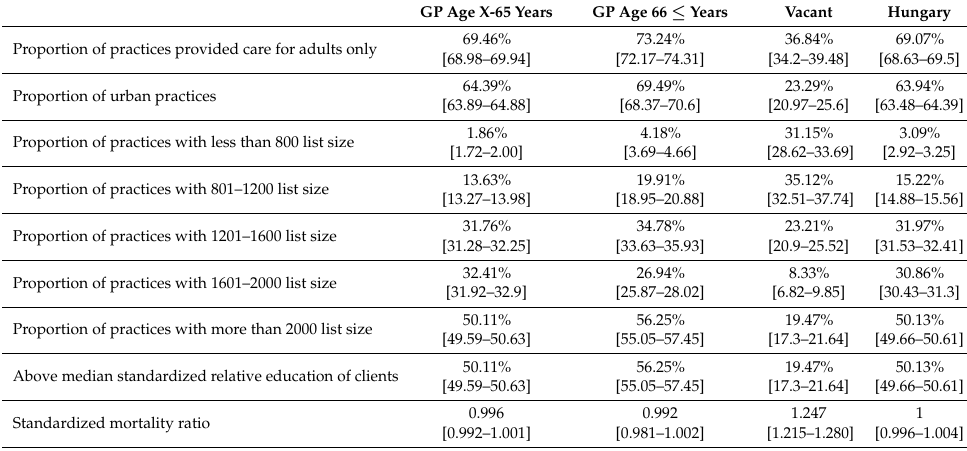
Table 2. Distribution of structural attributes and standardized mortality ratios of general medical practices according to the lack of permanent GP and to the age of GP in Hungary during 2006–2014 (with 95% confidence